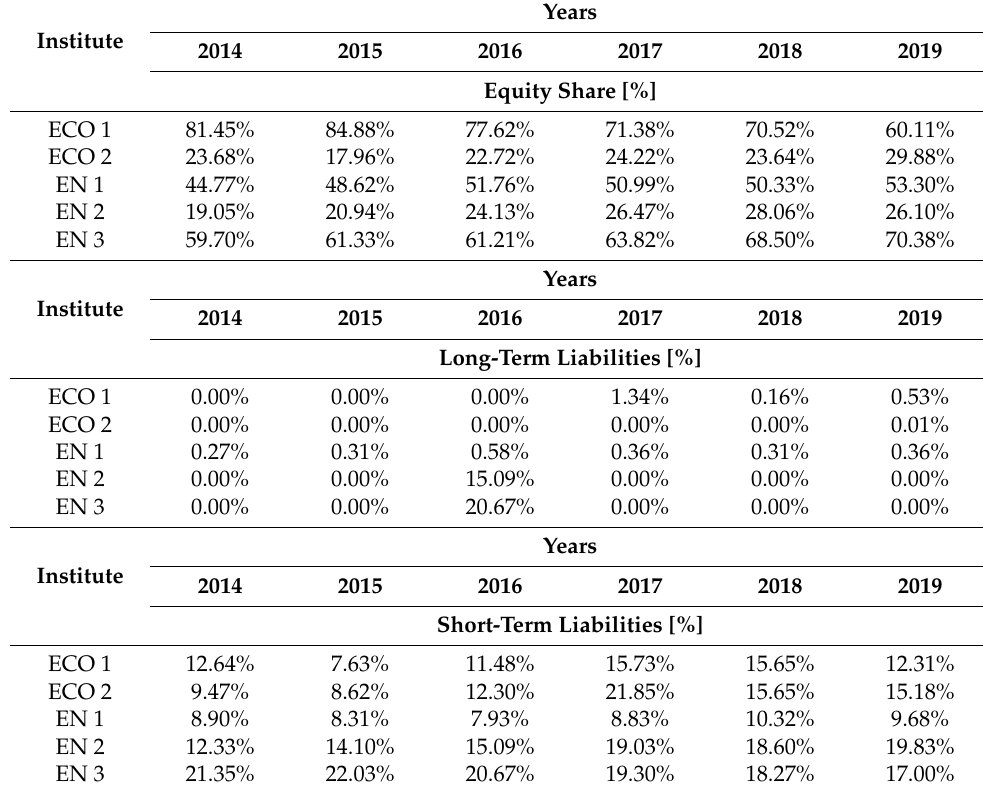
Table 2. Capital structure of the surveyed research institutes in